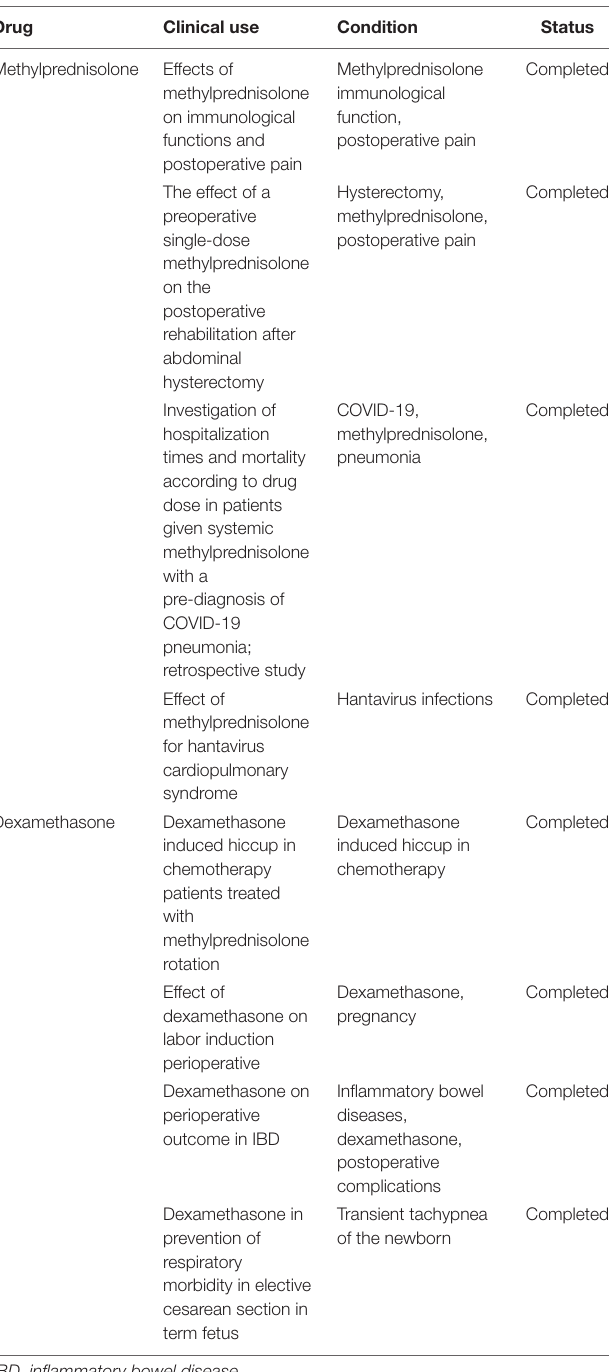
TABLE 3 | Clinical uses of methylprednisolone and dexamethasone (https://clinicaltrials.gov/). Drug Clinical use Condition Status Methylprednisolone Effects of